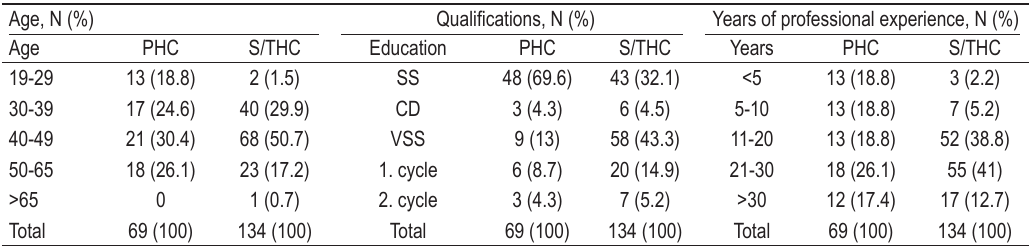
TABLE 1. Basic characteristics of examinees per levels of health care